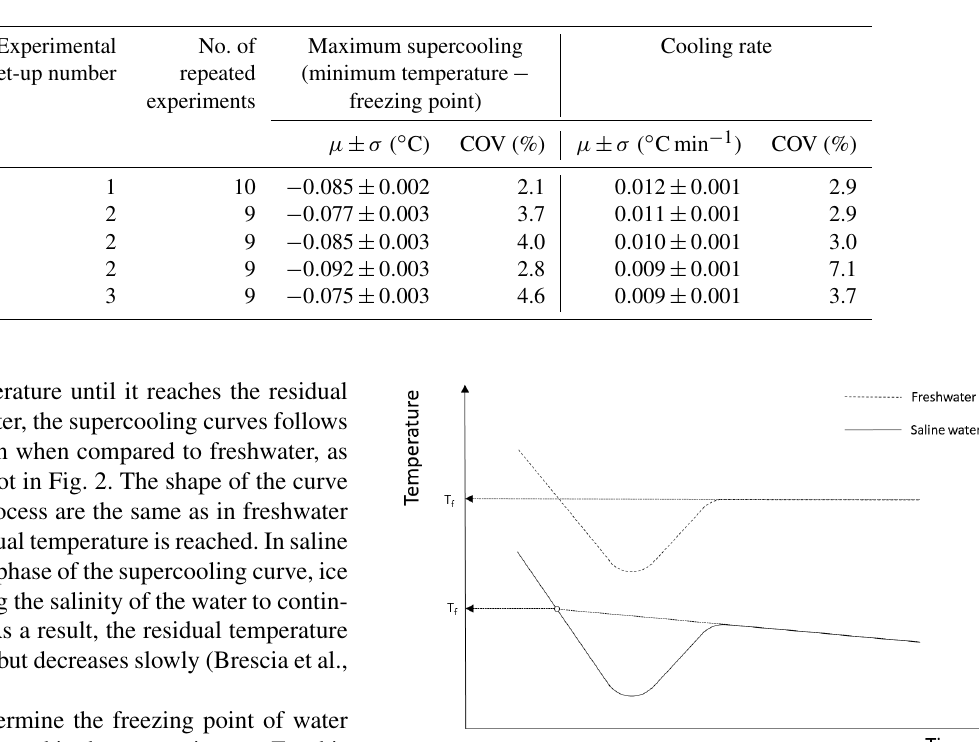
Table 2. Summary of statistics on the repeatability of experiments at each salinity showing the arithmetic mean µ , the corresponding standard deviation σ , and the coefficient of variation (COV) for the maximum supercooling and the cooling rate.